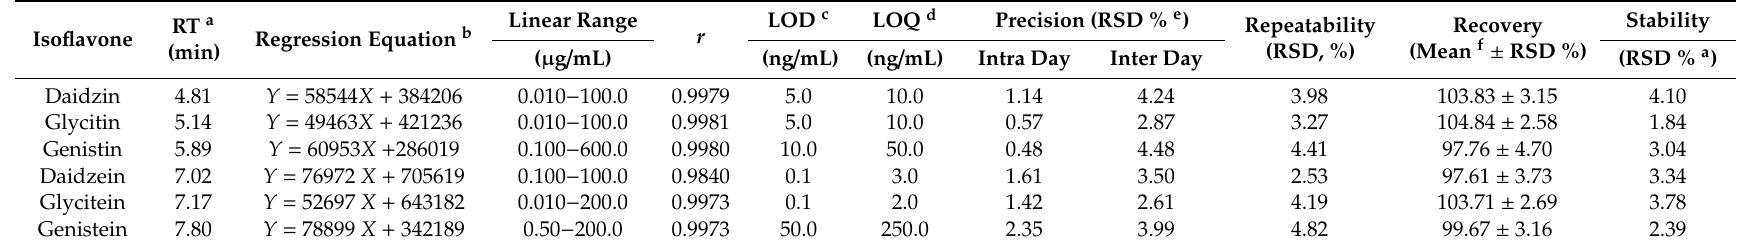
Table 3. Validation data of targeted